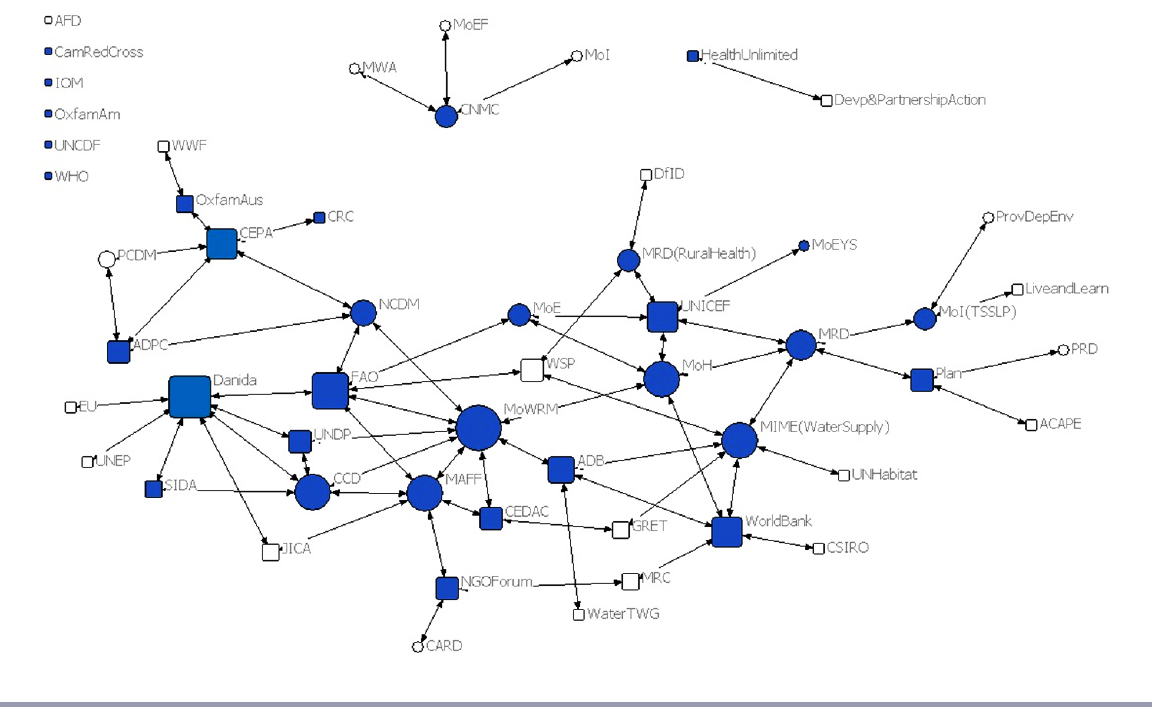
Fig. 3 . Water and climate change partnerships in